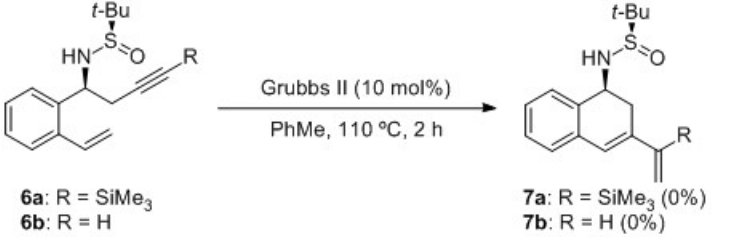
Figure 3 - Attempt to perform ring-closing metathesis of enynes 6